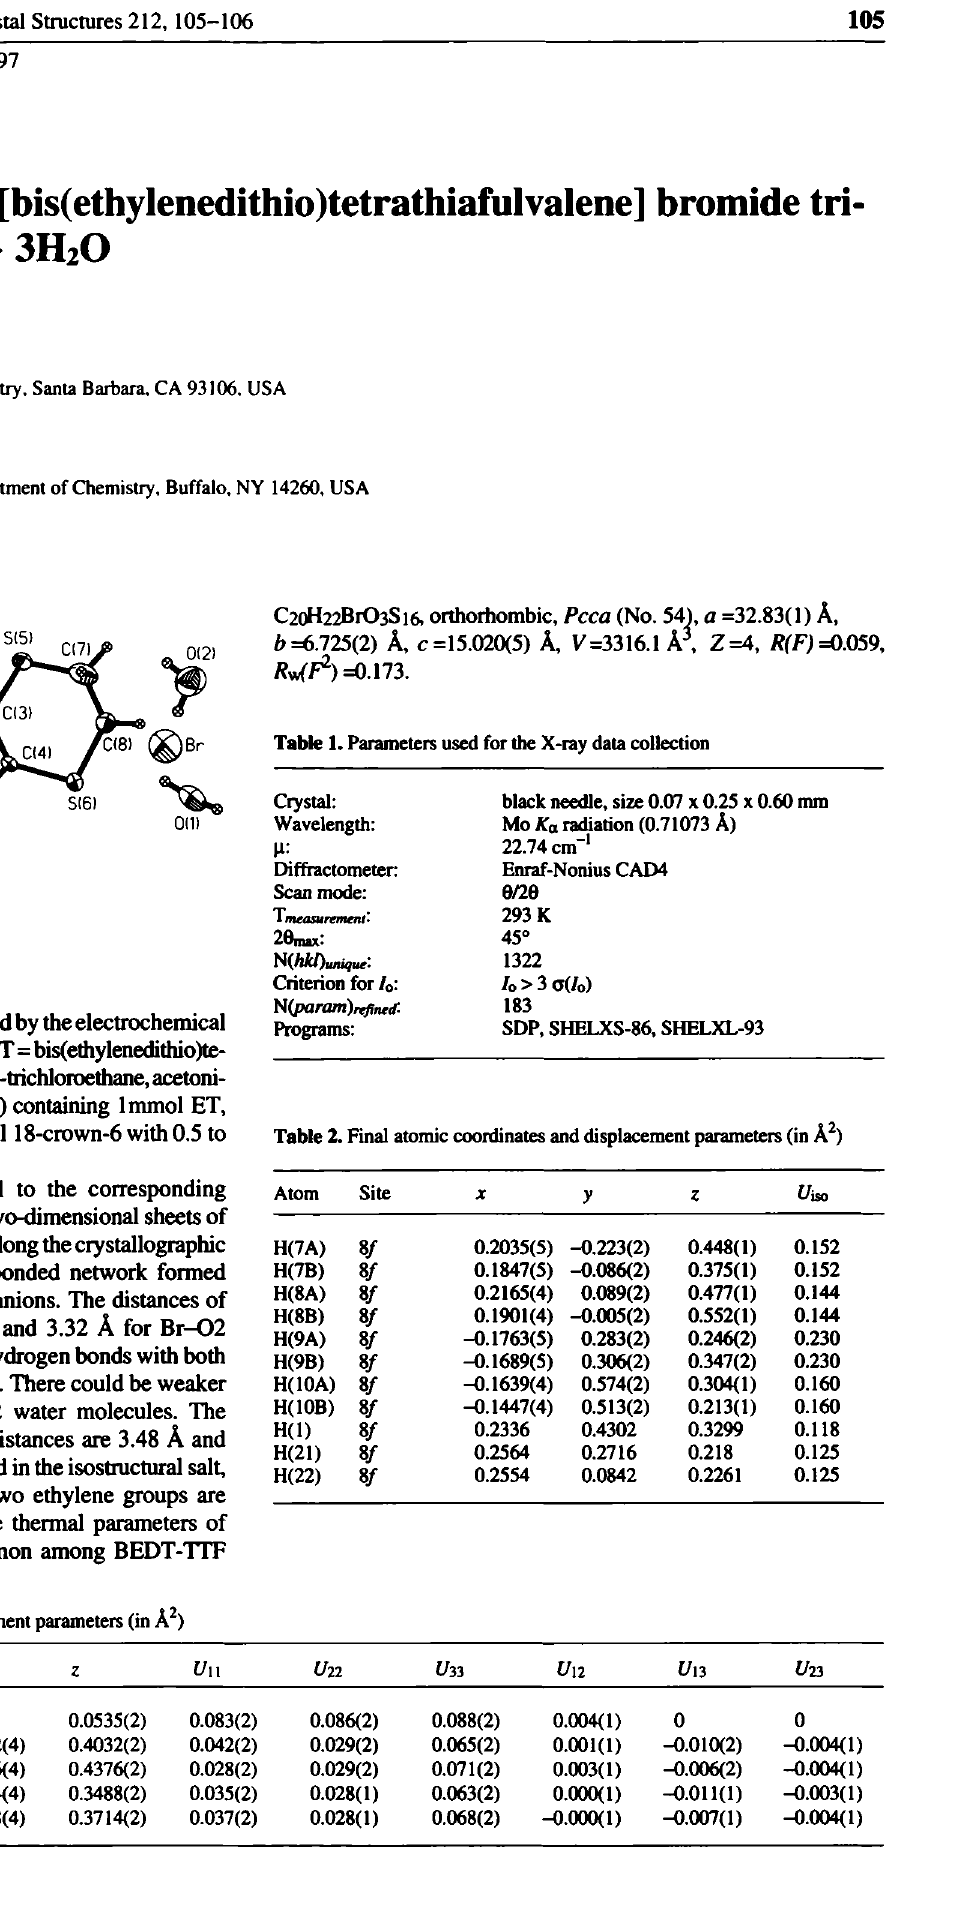
Table 3. Final atomic coordinates and displacement parameters (in Â 2 )